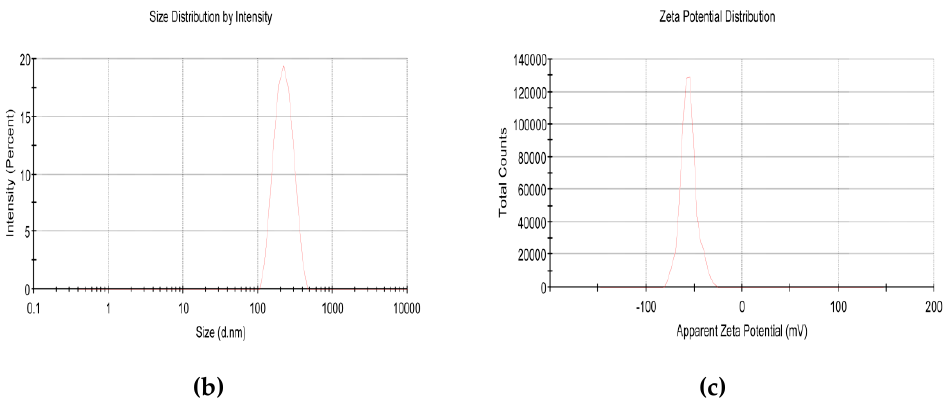
Figure 1. Physical properties of the CPhG liposomes: ( a ) Transmission electron microscopic image of the CPhG liposomes with a scale of 200 nm; ( b ) the laser particle size analyzer particle size distribution profile of the CPhG liposomes; ( c ) potentiometric analysis profile of the CPhG liposomes.